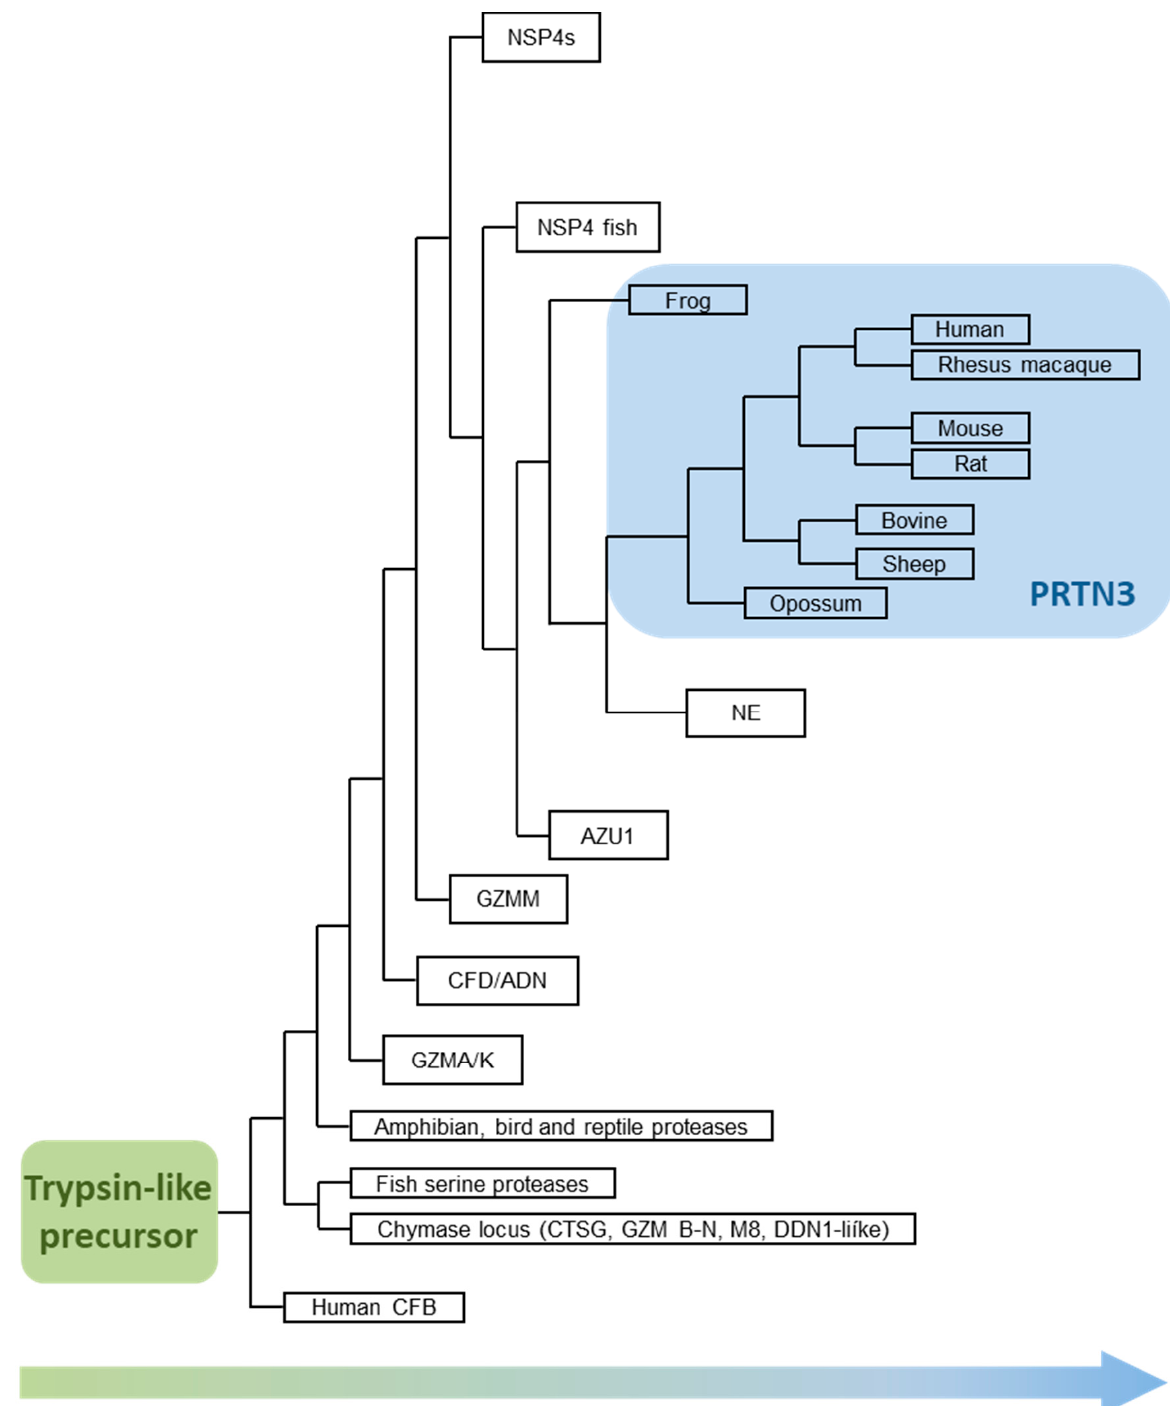
Figure 2. Phylogenetic tree of serine protease evolution towards PRTN3. (Adapted from [10] ).